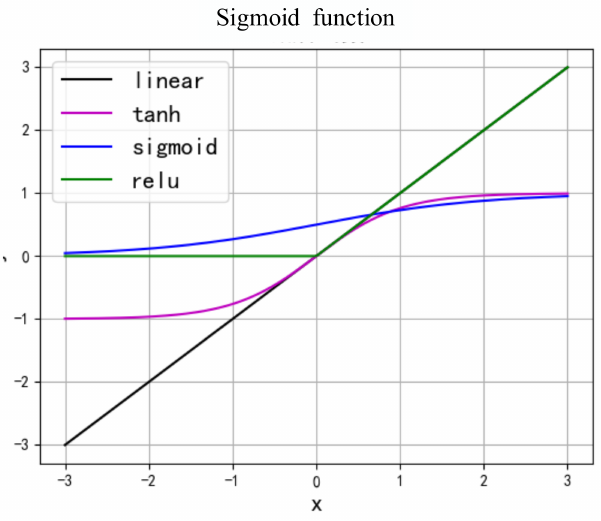
Figure 3. Sigmoid function